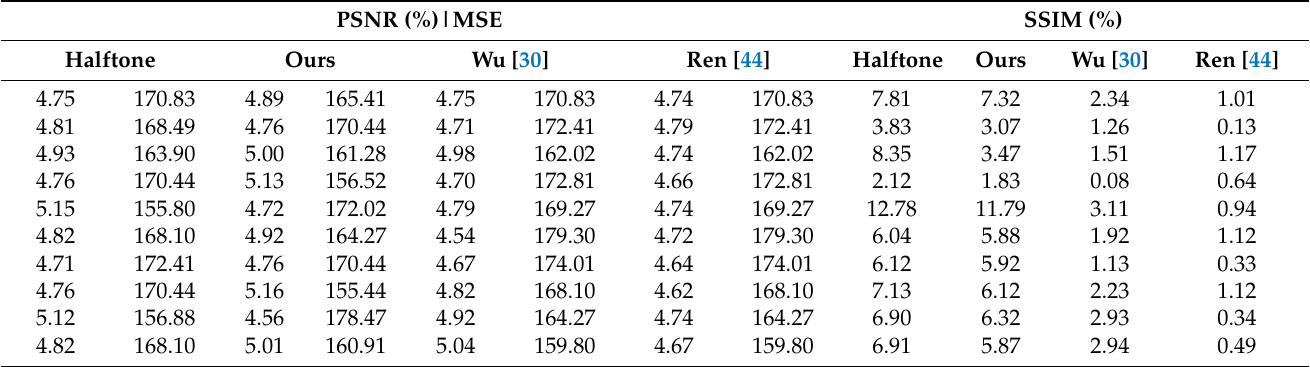
Table 2. The comparisons of image quality from the original halftone, the proposed EVCS, Wu’s and Ren’s methods.